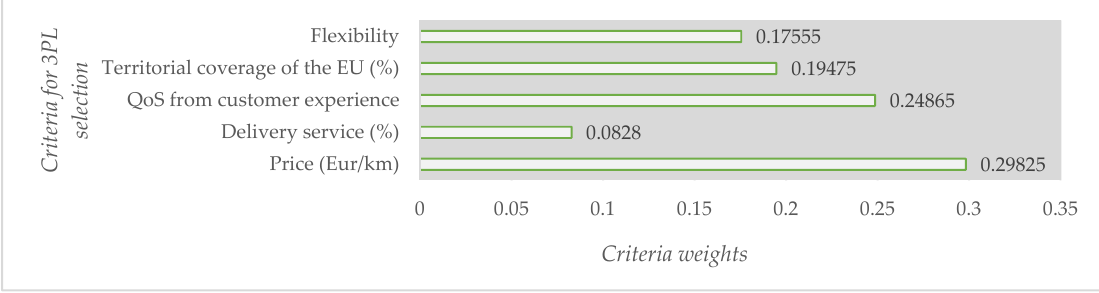
Figure 2. Obtained hybrid criteria weights (Source: Authors).